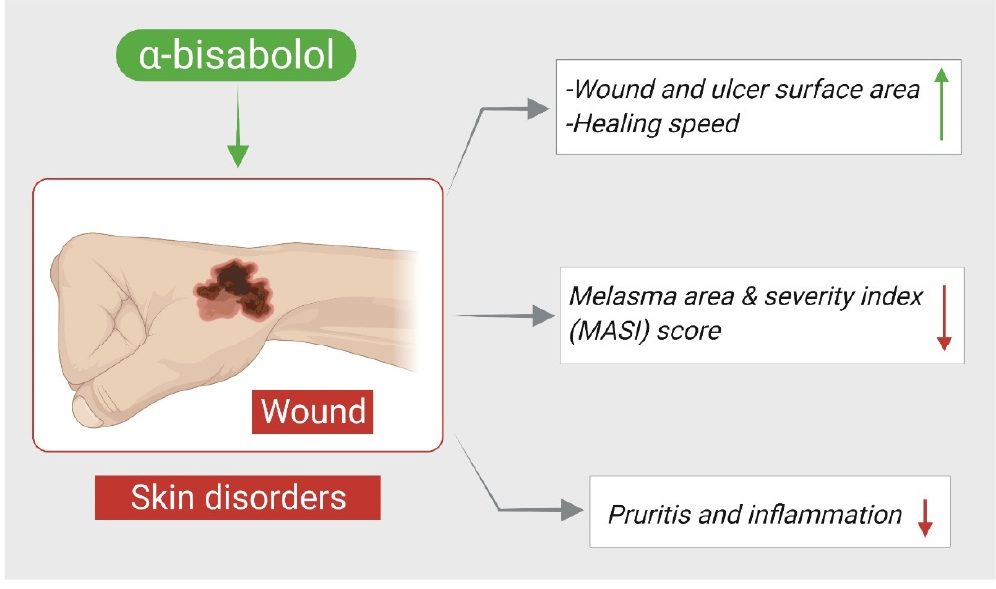
Figure 1. Effects of α -Bisabolol on skin disorders. ↑ ; increase, ↓ ;